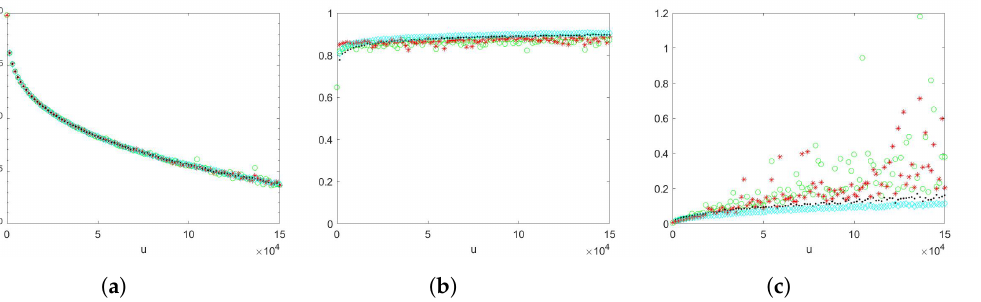
Figure 2. The random variable N is geometrically distributed with success probability p = 0.2, W i i.i.d ∼ Weibull ( 0.35,2 ) , X i i.i.d ∼ Erlang ( 2,3 ) , where i = 1, . . . , N . Green circles: ConAK2. Red stars: ConAK2+CV. Black dots: ConAK2+IS (conditioning and IS on Erlang using an exponential PDF). Cyan diamonds: ConAK2+IS+CV (conditioning and IS on Erlang using an exponential PDF). ( a ) Estimates of (cid:96) ( u ) as a function of u on a logarithmic scale. ( b ) Empirical logarithmic rates as a function of u . ( c ) Empirical relative errors as a function of u